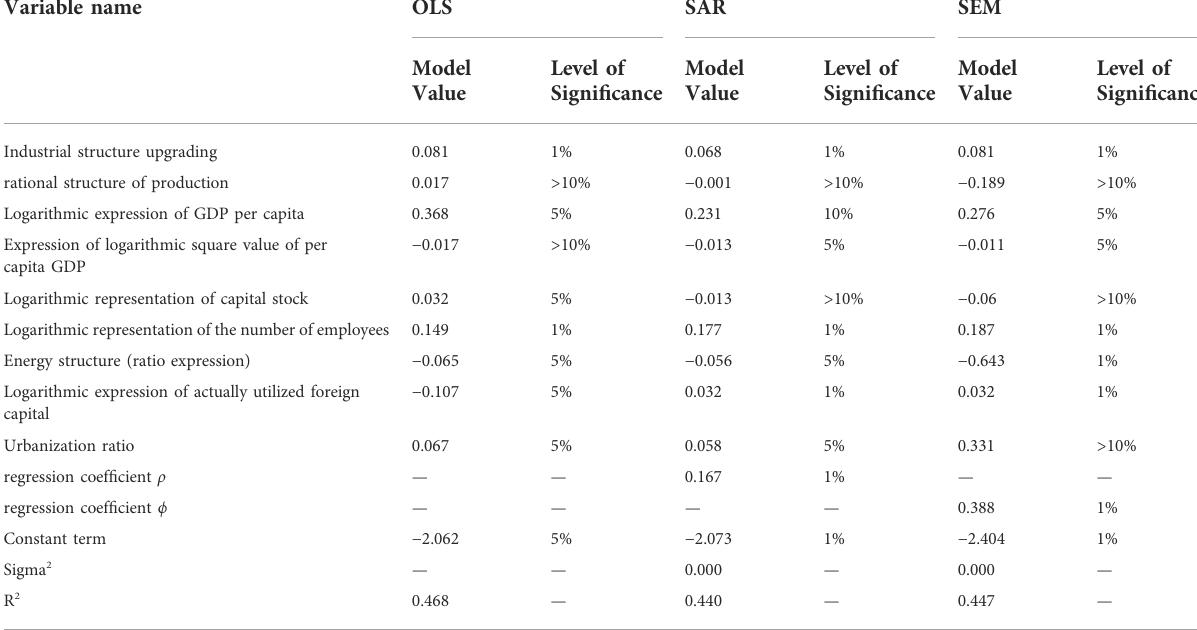
TABLE 3 Empirical analysis on the impact of industrial structure on ecological ef fi ciency of integrated urban agglomeration. Variable